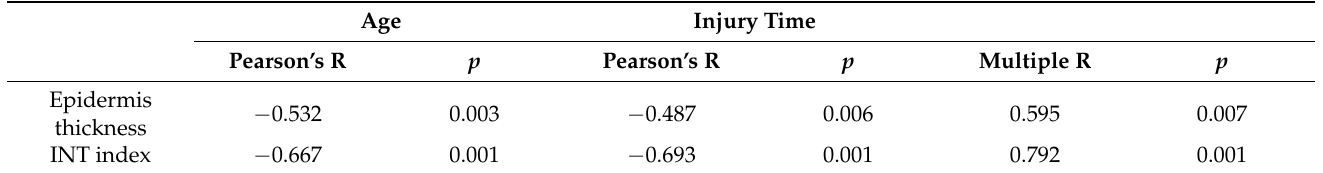
Table 2. Multiple regression analysis of the epidermis parameters (thickness and INT index) at baseline (pre-treatment) with both age and time from injury on LMNSCI before the h-bFES. Age Injury Time Pearson’s R p Pearson’s R p Multiple R p Epidermis